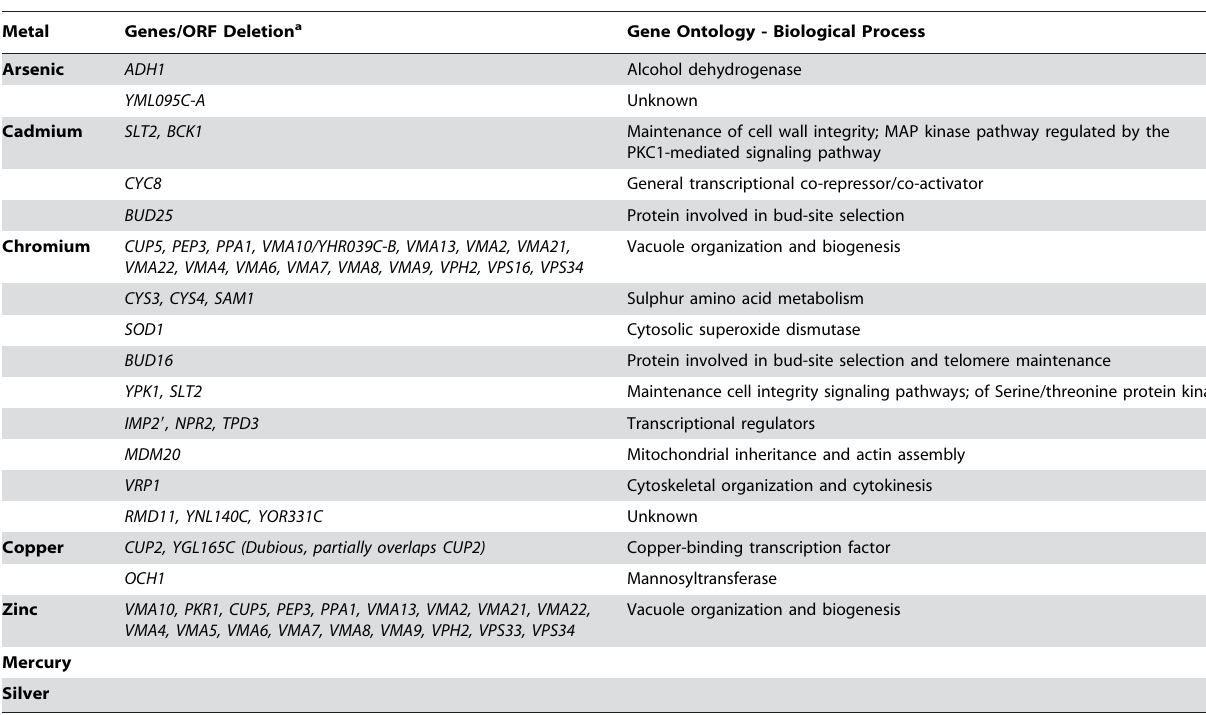
Table 3. Genes that are Essential for Resistance to Metal Toxicity.